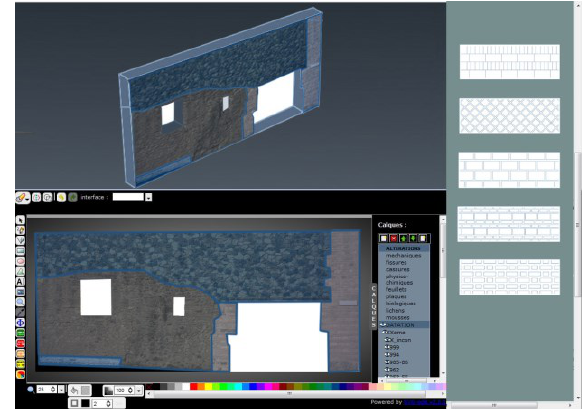
Figure 3. 3D information system for opus documentation